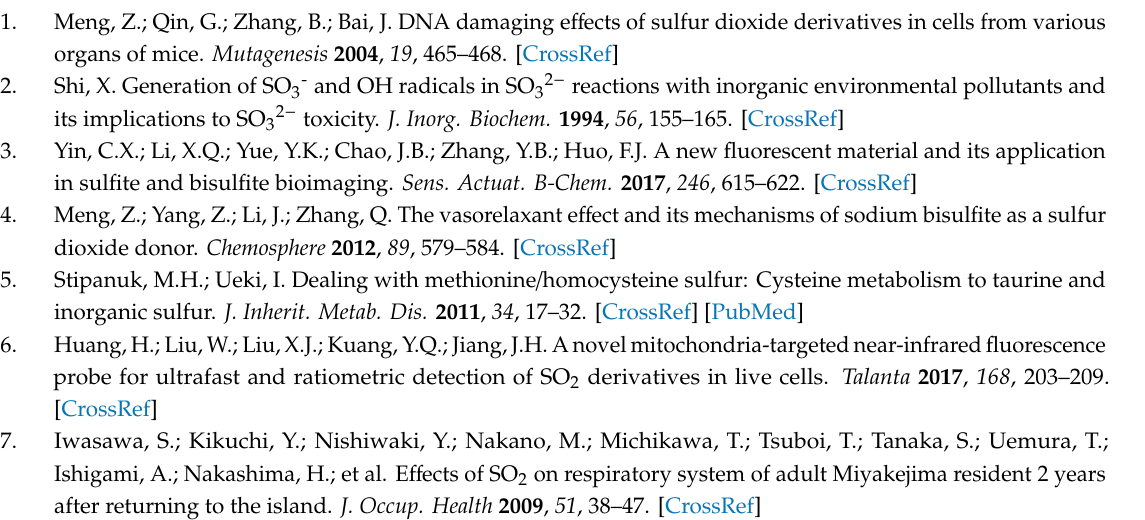
Supplementary Materials: The following are available online. Figure S1. 1 H-NMR spectrum of the probe in DMSO-d 6 ; Figure S2. 13 C-NMR spectrum of compound the probe in DMSO-d 6 ; Figure S3. Mass spectrum of compound the probe. Table S1: Comparison of the probe for the detection of SO 32 − / HSO 3 −